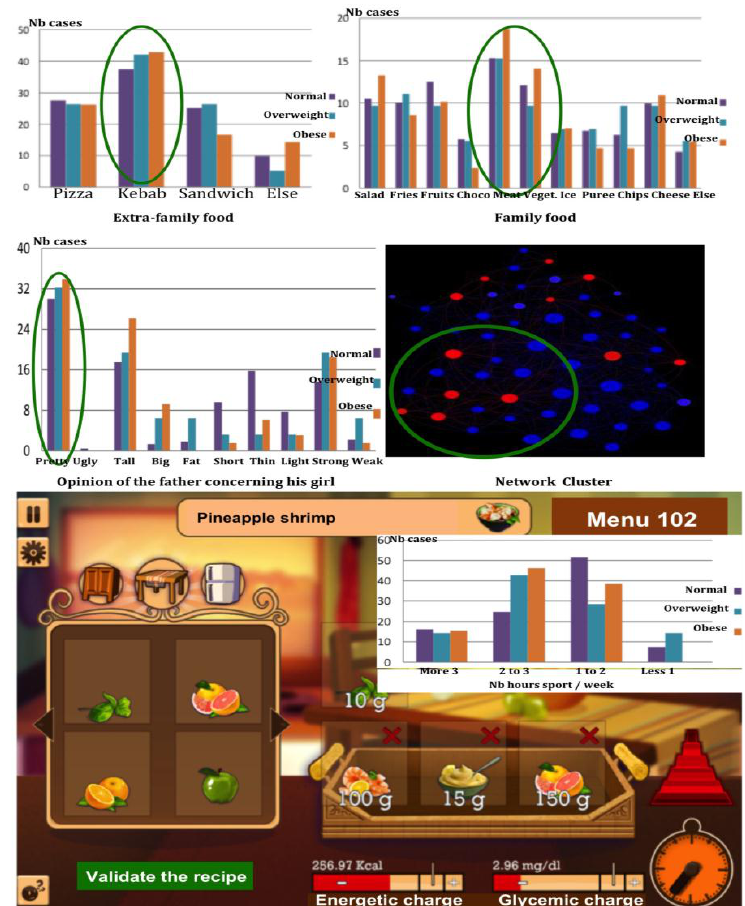
Figure 12. Sample screenshot of the diabetic nutrition game, showing how a menu is composed with a pineapple shrimp entree and the needs of the player in energetic and glycemic charges, in order to respect a predetermined daily activity and to take into account a priori information about his or her nutrition, sport and social individual